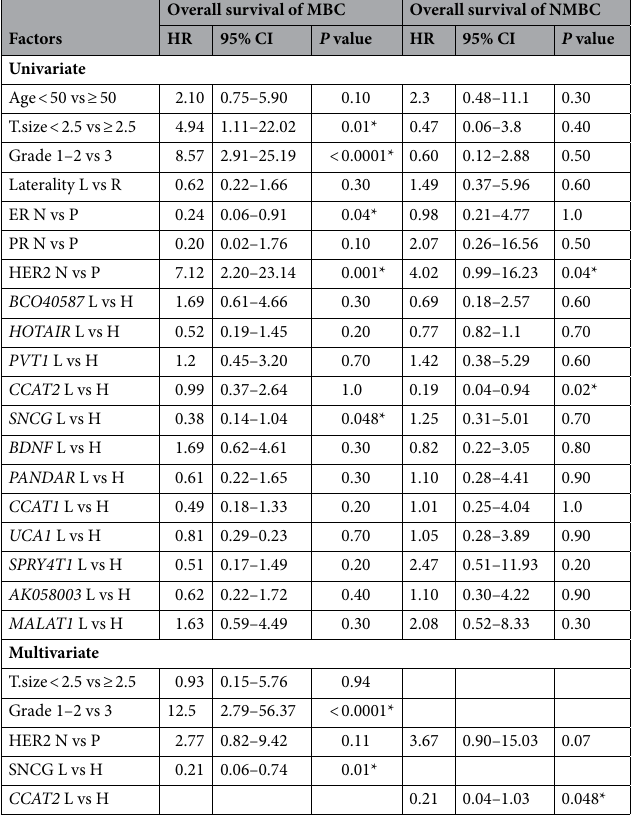
Table 3. Univariate and multivariate overall survival analysis of MBC and NMBC patients. HR; hazard ratio, CI; confidence interval, MBC; metastatic breast cancer, NMBC; non-metastatic breast cancer, T. size, tumor size, ER; estrogen receptor, PR; progesterone receptor, HER2; human epidermal growth factor